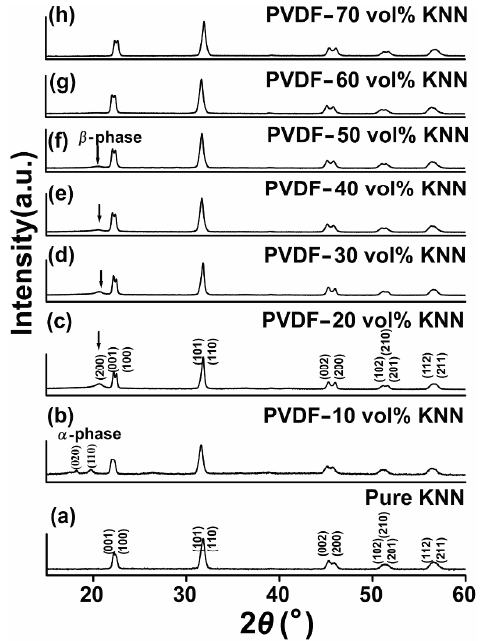
Fig. 2 XRD patterns for the hot-pressed PVDF–KNN microcrystal composites: (a) KNN powder containing micron-sized crystallites, (b) PVDF–10 vol% KNN, (c) PVDF–20 vol% KNN, (d) PVDF–30 vol% KNN, (e) PVDF–40 vol% KNN, (f) PVDF–50 vol% KNN, (g) PVDF–60 vol% KNN, and (h) PVDF–70 vol%